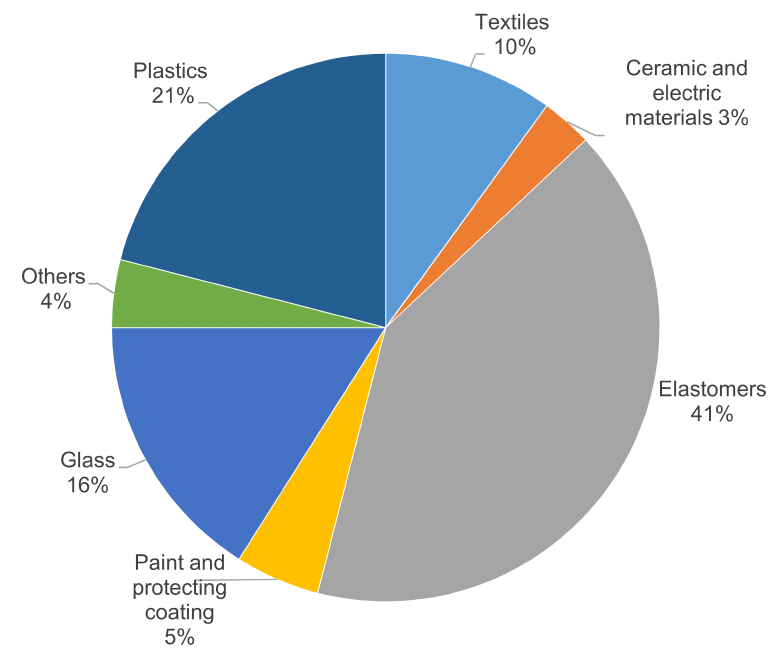
Figure 3. Ingredients of